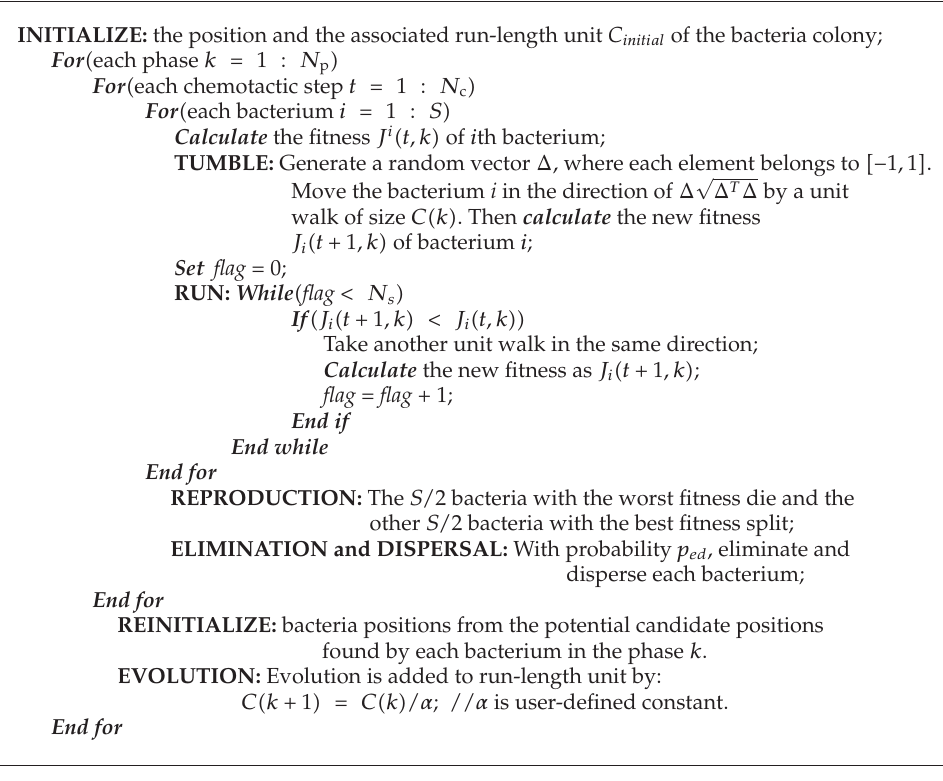
Algorithm 1: Pseudocode for